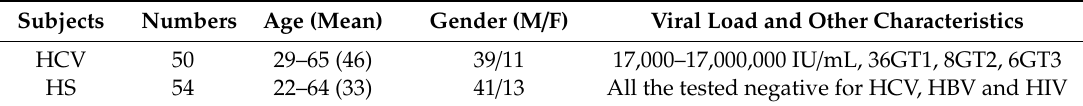
Table 1. Demographic information of the study